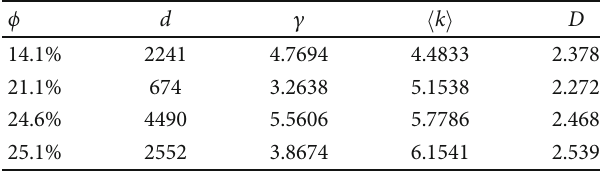
Figure 4: The process of simpli fi Table 1: The sides of seepage network is expressed by d , the power exponent is expressed by γ , the mean of nodal degree is expressed by k , and P ð k Þ ≈ k − γ .